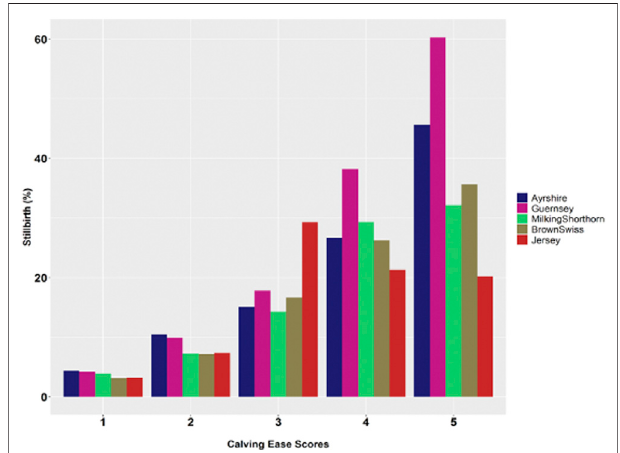
FIGURE 2 | Average population percentage of stillbirth (%SB) by calving easescorein fi venon-Holsteindairycattlepopulations(Calvingeasescores:1 = no problem, 2 = slight problem, 3 = needed assistance, 4 = considerable force, and 5 = extreme dif fi culty).